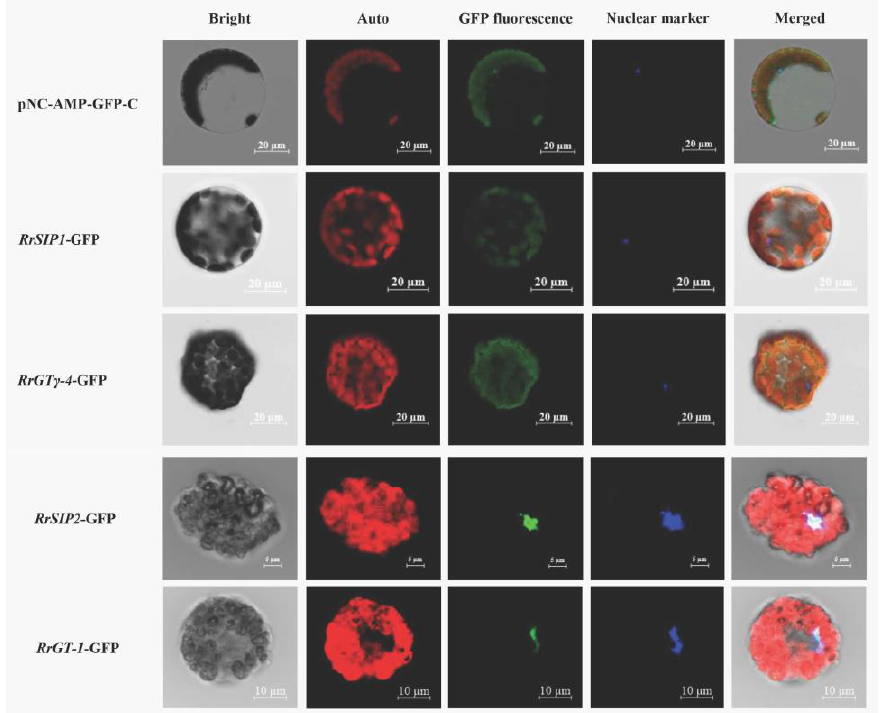
Figure 6. The subcellular localizations of RrGTγ -4 , RrSIP1 , RrSIP2 and RrGT-1 . Arabidopsis proto- plasts transformed by GFP empty vector (pNC-AMP-GFP-C) or 35S: GTs -GFP vectors were observed using the laser confocal microscopy. The merged figures (Merged) were based on bright fields (Bright) and fluorescence of chloroplasts (Auto), green fluorescent protein (GFP), 4’,6-diamidino-2-phenylindole (DAPI, Nuclear marker) on dark fields.